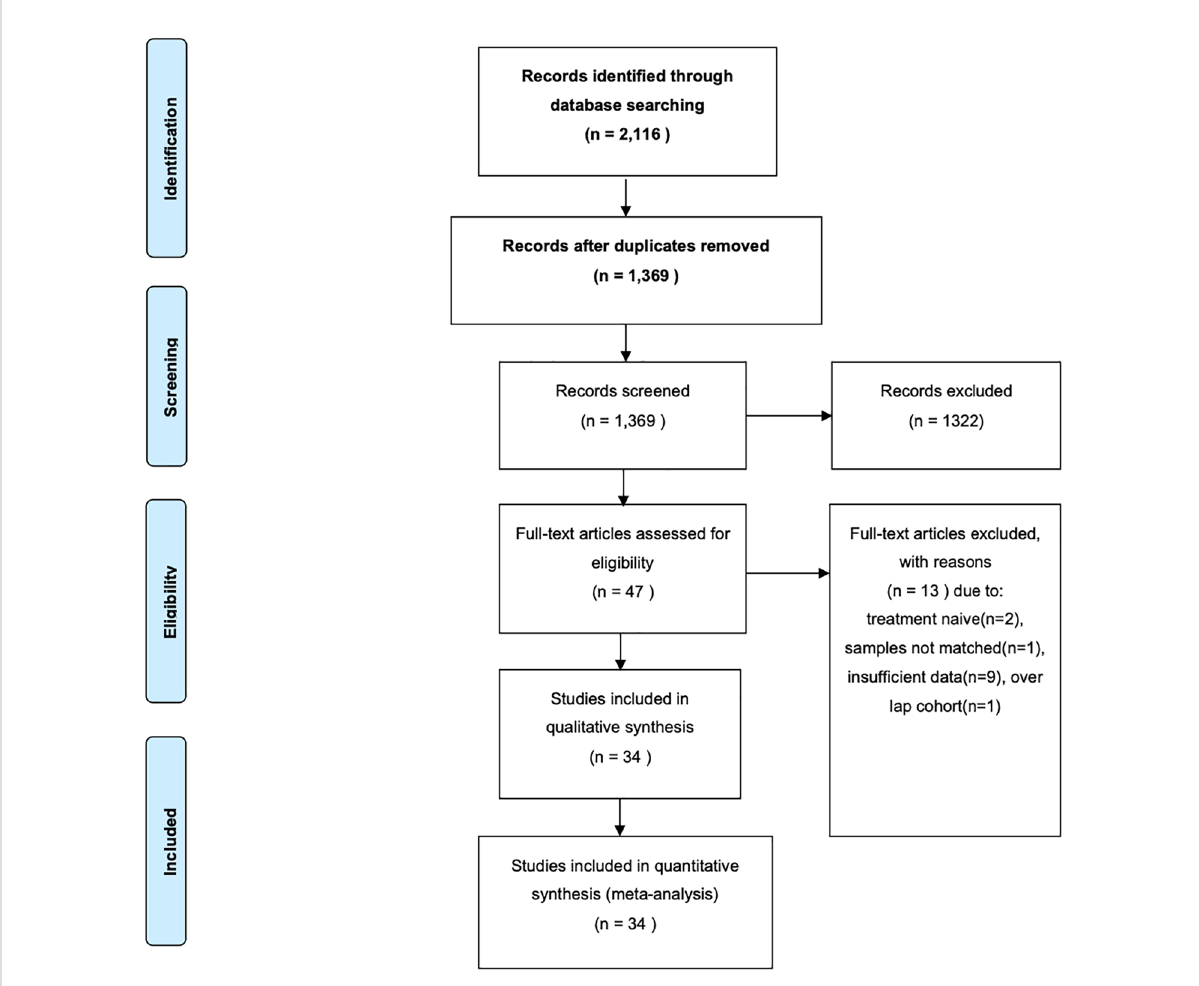
FIGURE 1 Flow Diagram of search and study selection in this